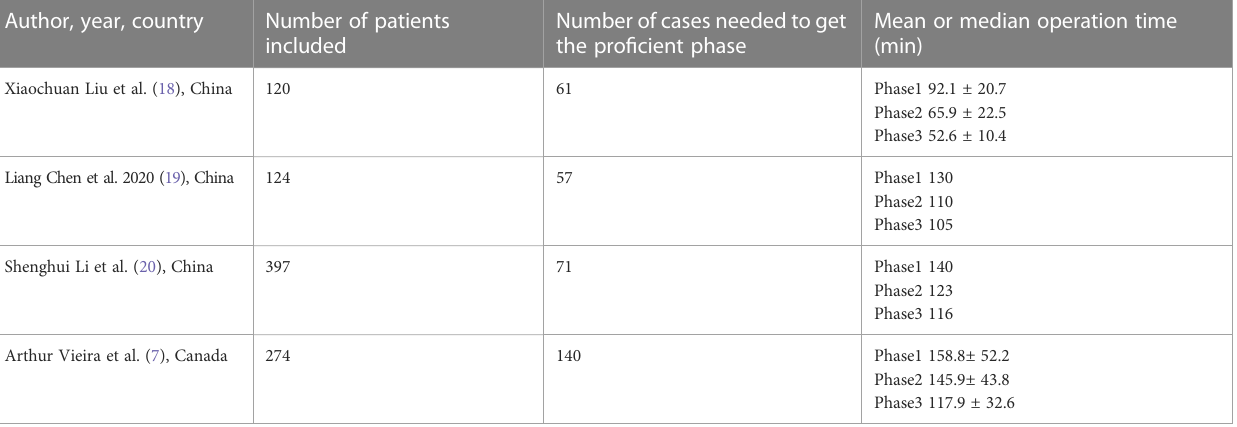
TABLE 2 Surgical outcomes of previous U-VATS